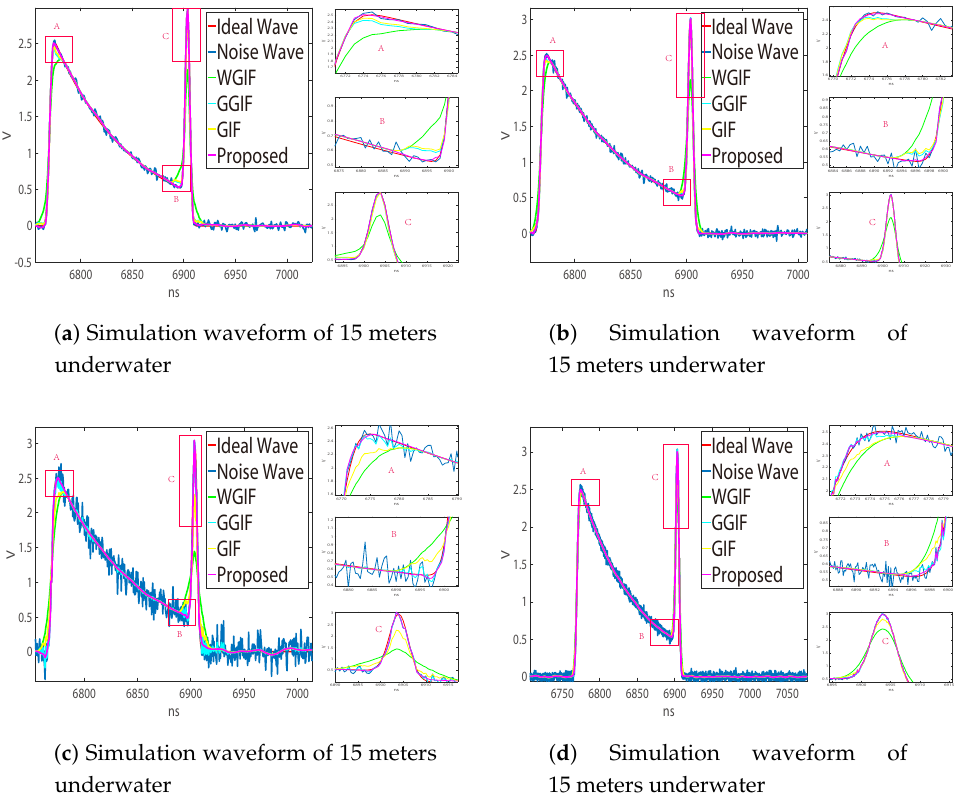
Figure 8. Measured waveform noise suppression effect. ( a ) Filtering effect at f p = 1 GHz, SNR = 30. δ = 4 in WGIF, GGIF, and GIF, δ = 3–5 in AGGF (proposed). ( b ) Filtering effect at f p = 2 GHz, SNR = 30. δ = 6 in WGIF, GGIF, and GIF, δ = 4–8 in AGGF (proposed). ( c ) Filtering effect at f p = 2 GHz, SNR = 20. δ = 10 in WGIF, GGIF, and GIF, δ = 8–12 in AGGF (proposed). ( d ) Filtering effect at f p = 7.5 GHz, SNR = 30. δ = 11 in WGIF, GGIF, and GIF, δ = 9–13 in AGGF